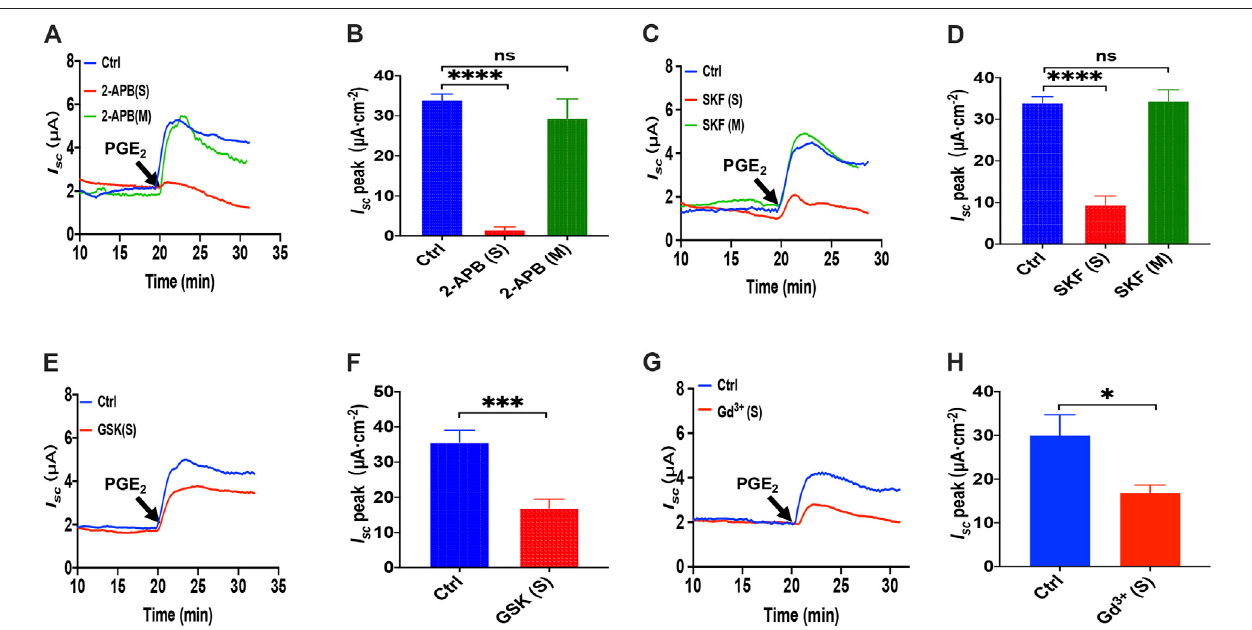
FIGURE 2 | PGE 2 induced Ca 2+ -dependent ion secretion by serosal SOCE mechanism in mice duodenum. (A) Time course of PGE 2 (10 μ M) -evoked I sc after mucosal or serosal application of 2-aminoethoxydiphenyl borate (2-APB, 100 μ M, n (cid:2) 6). (B) PGE 2 -evoked I sc peak after 2-APB was added to the serosal or mucosal side. (C) TimecourseofPGE 2 -evoked I sc aftermucosalorserosalapplicationofSKF-96365(SKF,30 μ M, n (cid:2) 6). (D) PGE 2 -evoked I sc peakafterSKF-96365wasadded to the serosal or mucosal side. (E) Time course of PGE 2 -evoked duodenal I sc after serosal application of GSK-7975A (GSK, 100 μ M, n (cid:2) 6). (F) PGE 2 -evoked duodenal I sc peak after serosal application of GSK-7975A. Ctrl represents the control without drug treatment. (G) Representative of the time course of PGE 2 -stimulated duodenal I sc after serosal addition of GdCl 3 (Gd 3+ , 30 μ M, n (cid:2) 6). (F) Summary of the effect of GdCl 3 on PGE 2 -stimulated duodenal I sc peak after serosal addition. Ctrl represents the control without drug treatment. Results are presented as mean ± SE. NS, no signi fi cant differences, * p < 0.05, *** p < 0.001, **** p < 0.0001 vs. corresponding control by Student ’ s unpaired, two-tailed t-test or one-way ANOVA followed Dunnett ’ s